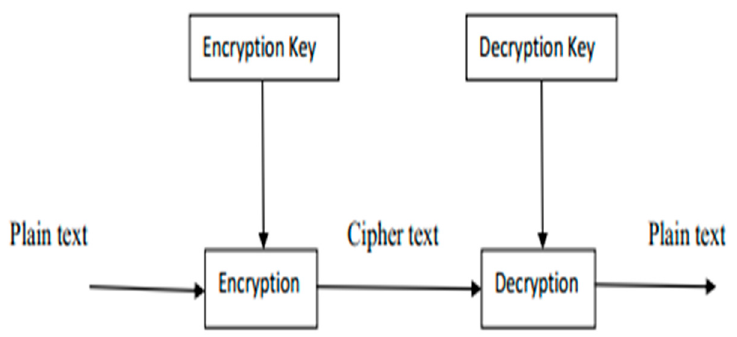
Figure 3. Asymmetric key cryptography.